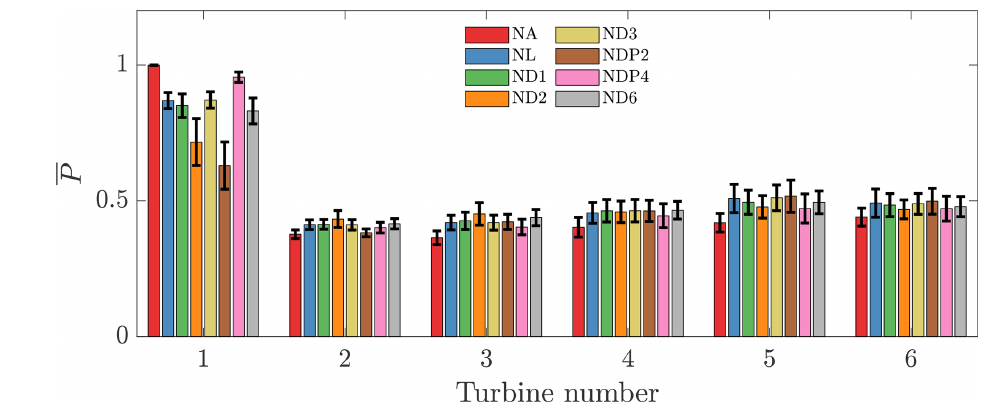
Figure 6. Time-averaged power production for each turbine in each wake steering case. The error bars denote 1 standard deviation in the power production. The power production is normalized by the leading turbine P 1 in baseline control conditions.